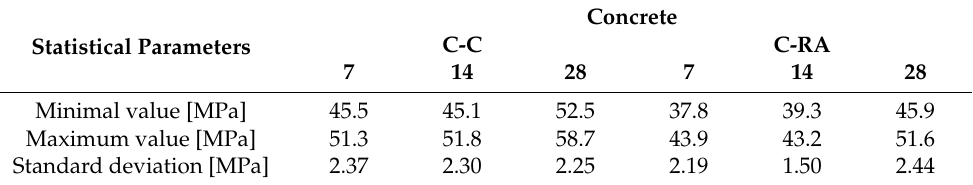
Figure 1. Change in the average compressive strength of concretes of the C-C and C-RA series as a function of the curing period. Table 10. Statistical parameters for the compressive strength feature. Statistical Parameters